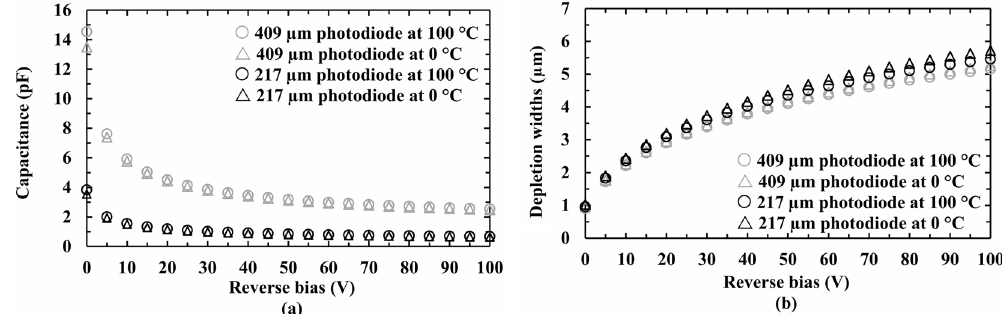
Figure 1. ( a ) Measured capacitances and ( b ) calculated depletion widths as functions of applied reverse bias for the 217 µ m diameter photodiode (100 °C, black open circles; 0 °C, black open triangles) and 409 µ m diameter photodiode (100 °C, grey open circles; 0 °C, grey open